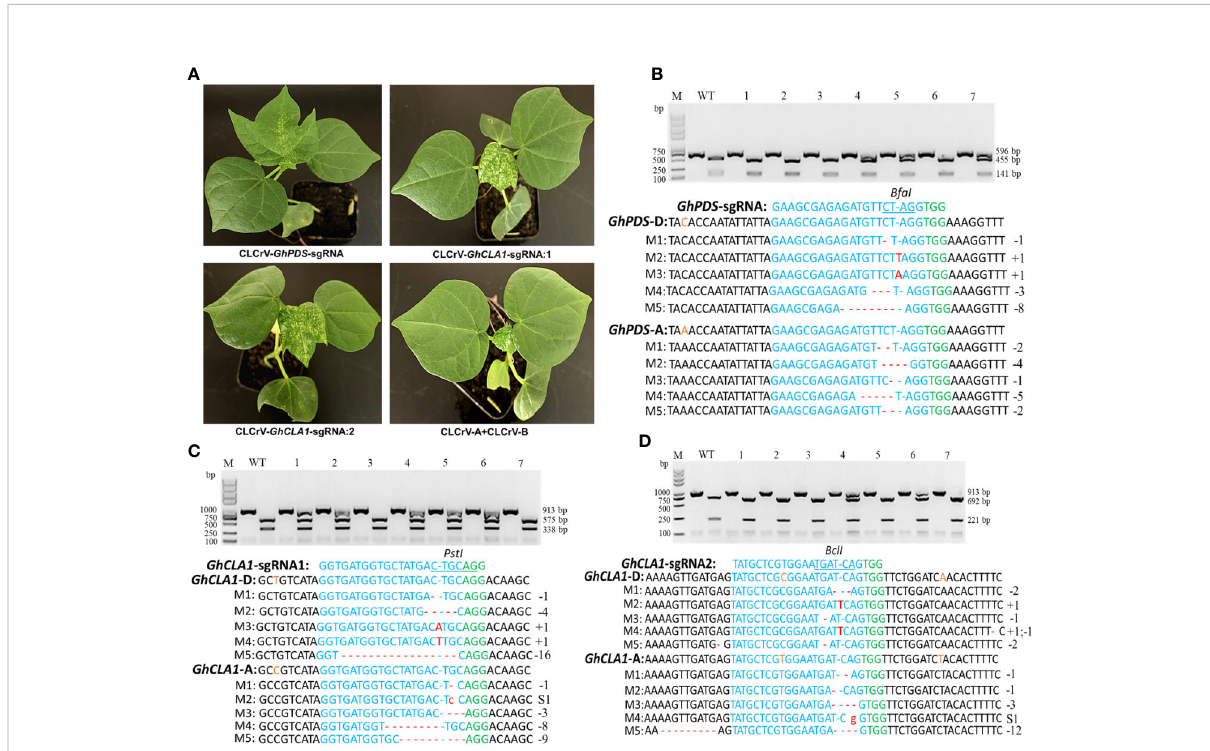
FIGURE 3 CLCrV-mediated targeted editing of GhCLA1 and GhPDS genes in cotton. (A) 20 to 27 days after in fi ltration, some plant leaves of GhPDS - sgRNA, GhCLA1 -sgRNA1 and GhCLA1 -sgRNA2 showed a yellow phenotype. Inoculated CLCrV-A and CLCrV-B empty vector cotton served as a control. (B) Detection of GhPDS -sgRNA targeted mutations. Wild-type served as a control, and 1-7 were plant numbers. The gel image shows PCR products of the GhPDS gene and digested PCR products with Bfa I, the undigested PCR products lacking the Bfa I site (due to